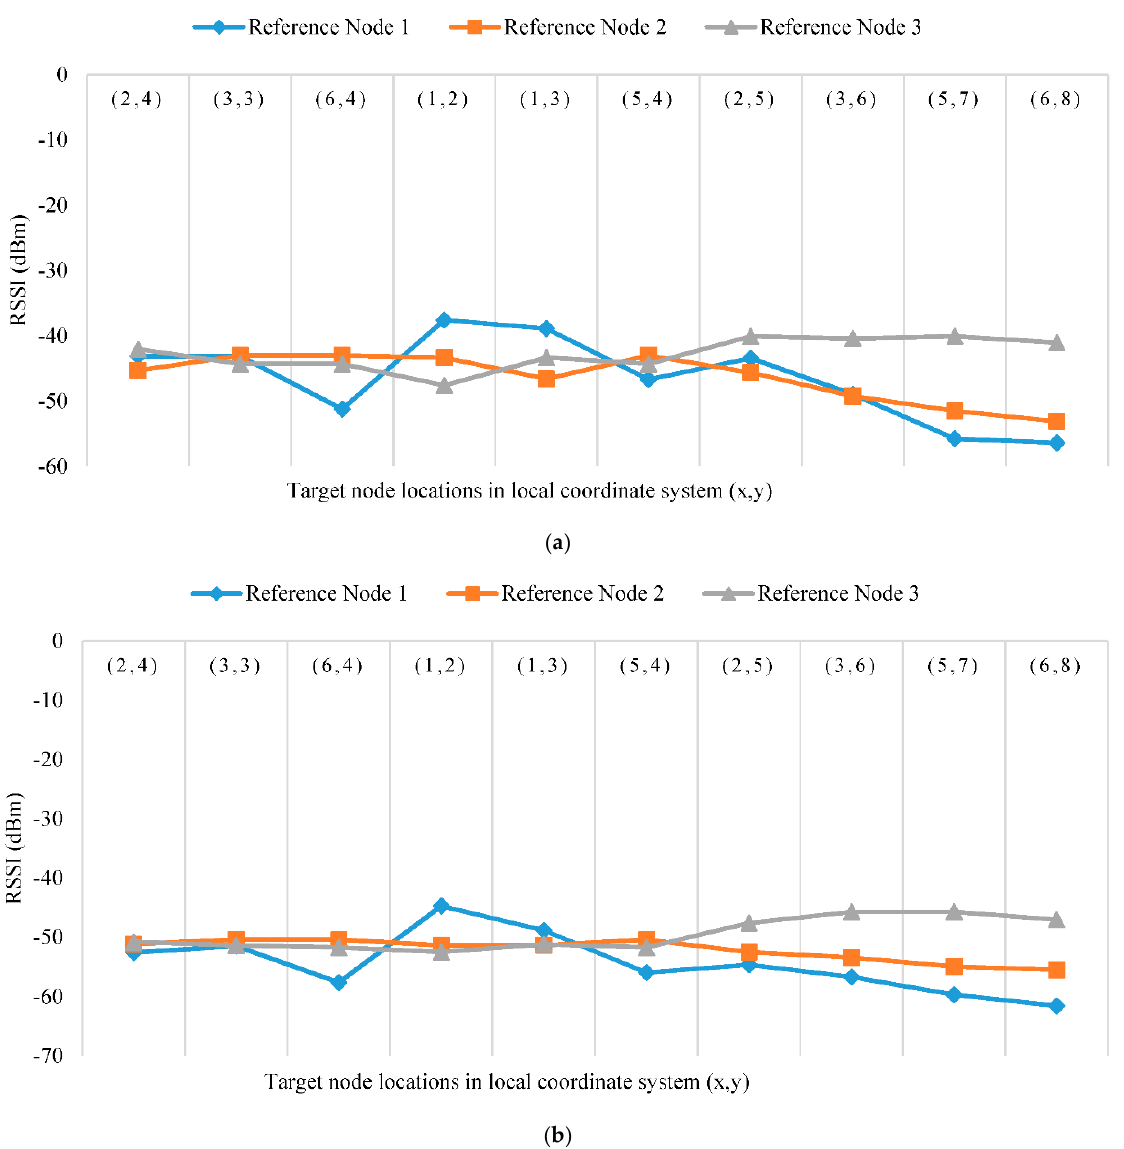
Figure 11. Average measured RSSI for ( a ) indoor experiments, and ( b ) outdoor experiments at ten different locations of target nodes.